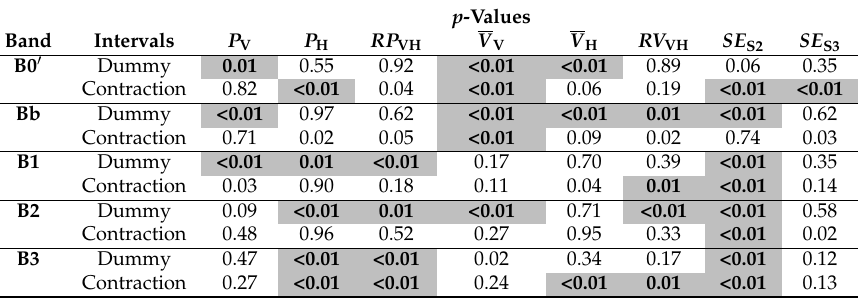
Table 4. p -values of newly defined EHG propagation features and of sample entropy of the original EHG signals S2, SE S2 , and S3, SE S3 . p -values ≤ 0.01 are shaded in